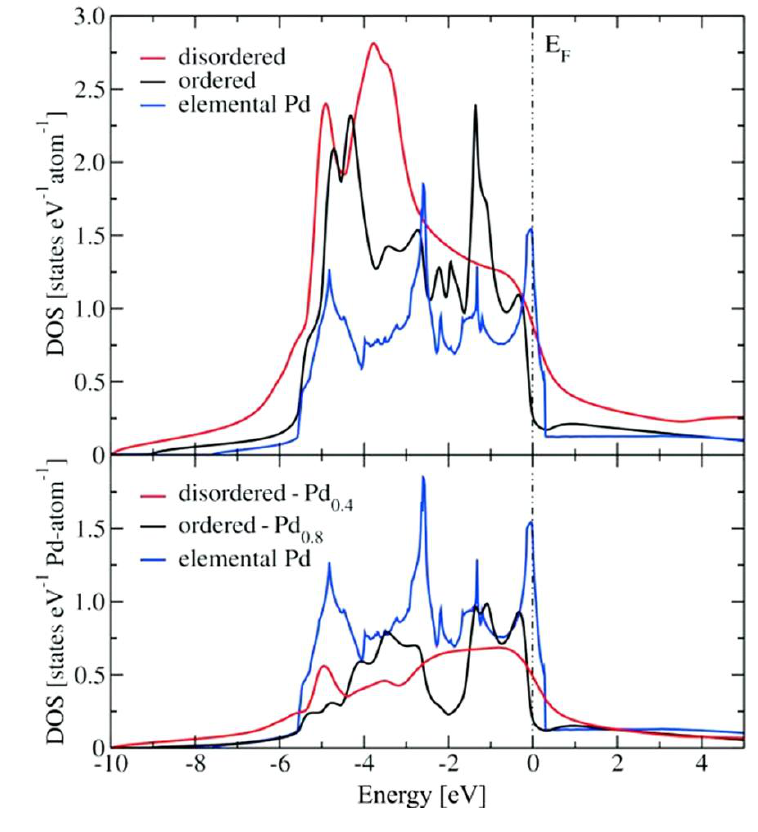
Figure 6. Total density of states (DOS) of the ordered and disordered Cu modifications (top panel, Fermi level (E modifications are depicted in the bottom panel. The DOS of elemental Pd is shown for